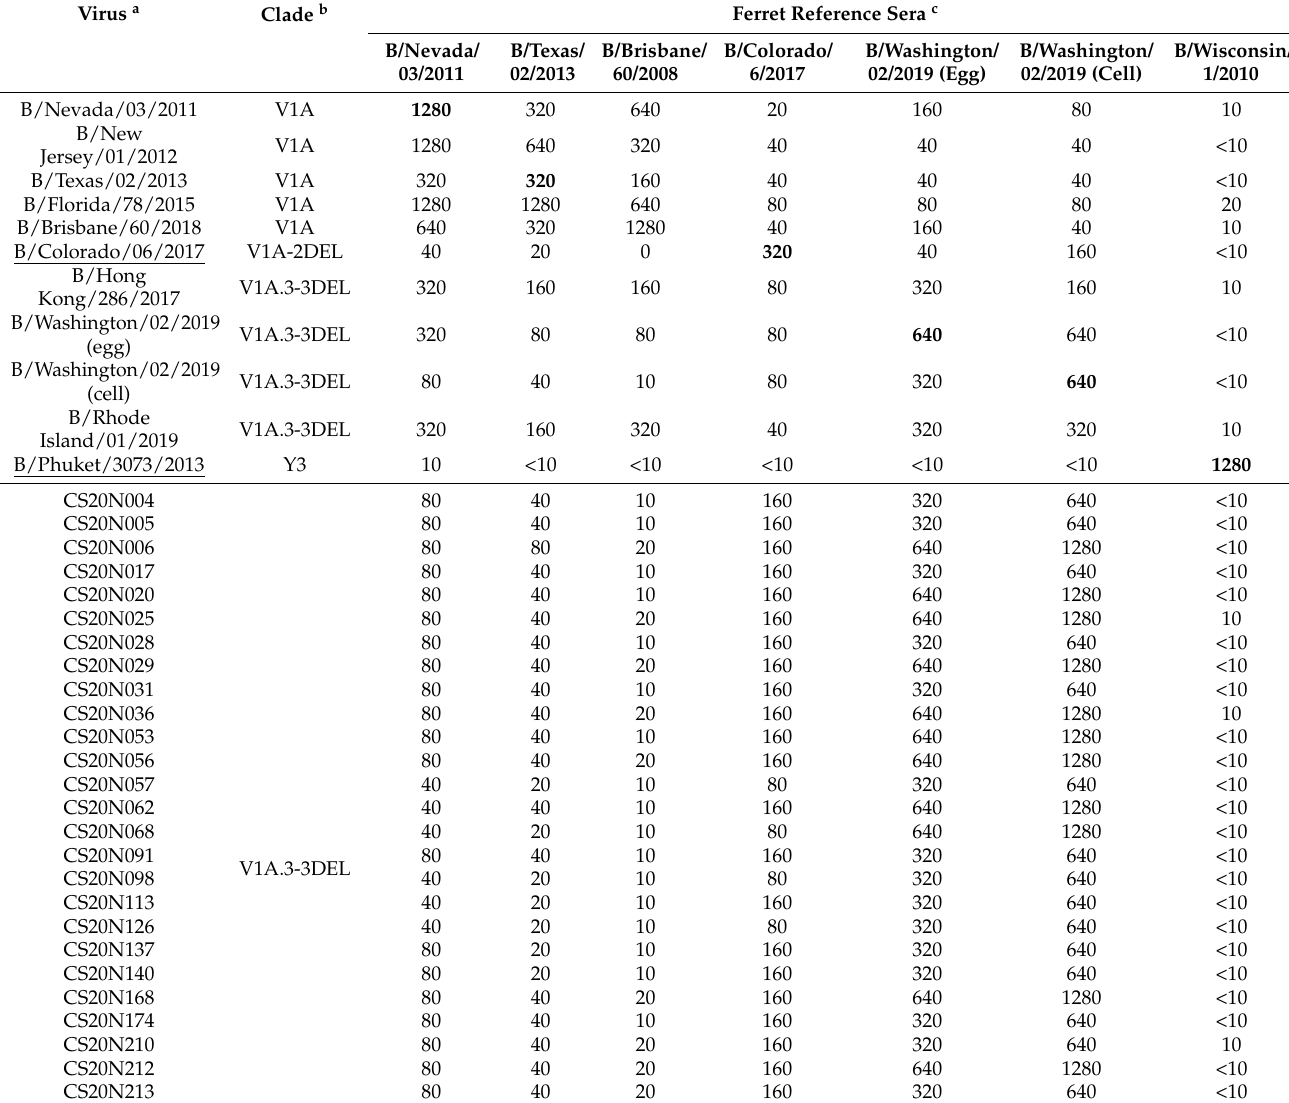
Table 4. Hemagglutination inhibition results of influenza B virus isolates (2019–2020) using ferret antisera. Virus a Clade